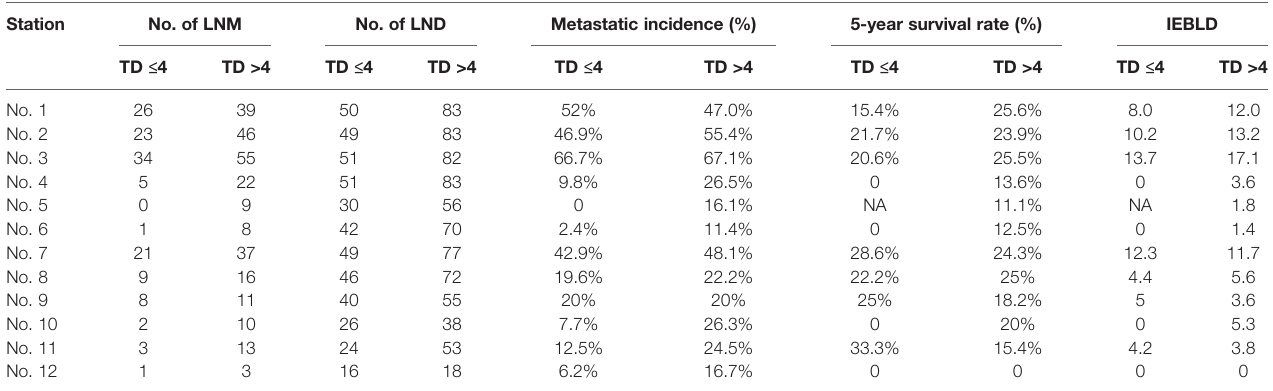
TABLE 5 | Therapeutic value index of each lymph node station in Siewert type III AEGs based on tumor diameter. Station No. of LNM No. of LND Metastatic incidence